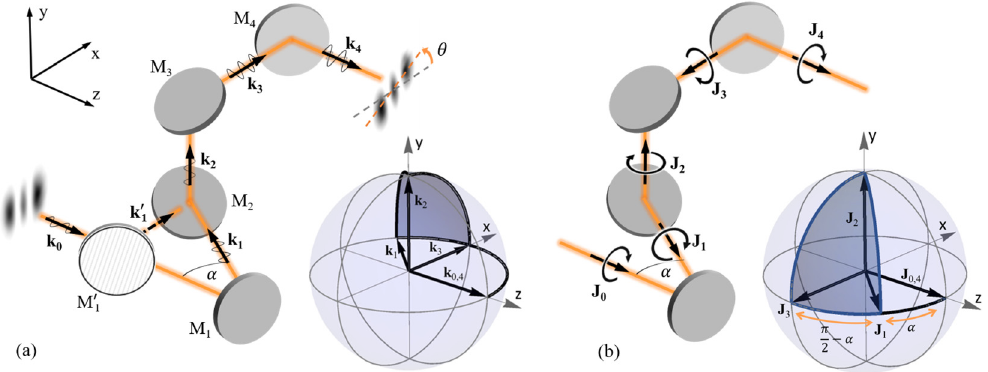
-sphere and angular momentum sphere. n labelling the wave vector after reflection off the n (as indicated by M ′ ) and is parametrized by the angle 𝛼 . 1 1 ) at the input and output plane, and indicate the change of the polarization 2 , 0 is aligned with the initial wave vector k . The 0 0